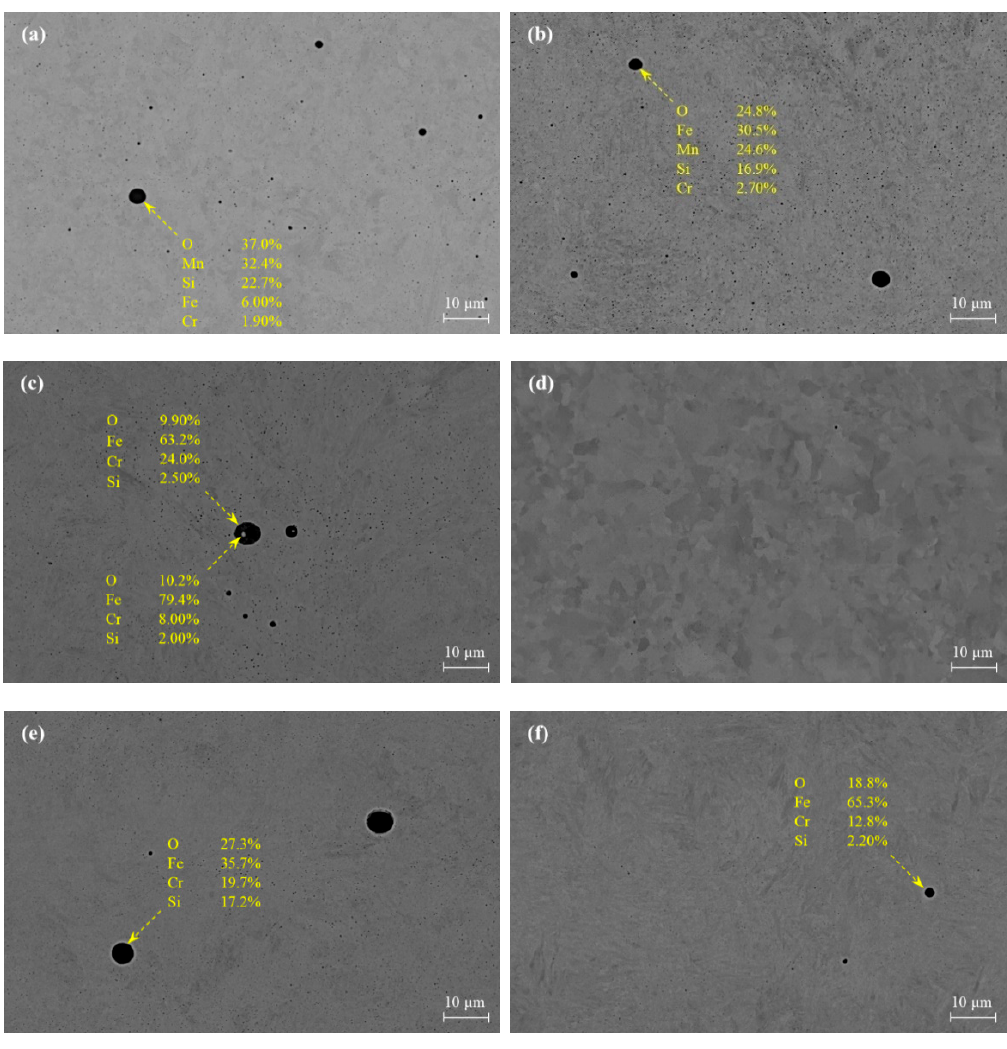
Figure 2. Field-emission scanning electron microscope ( FE-SEM) micrographs of ( a ) W-1, ( b ) W-2, ( c ) W-3, ( d ) W-4, ( e ) WT-1 and ( f ) WT-2 L-PBF processed alloys revealing the nonmetallic inclusions.